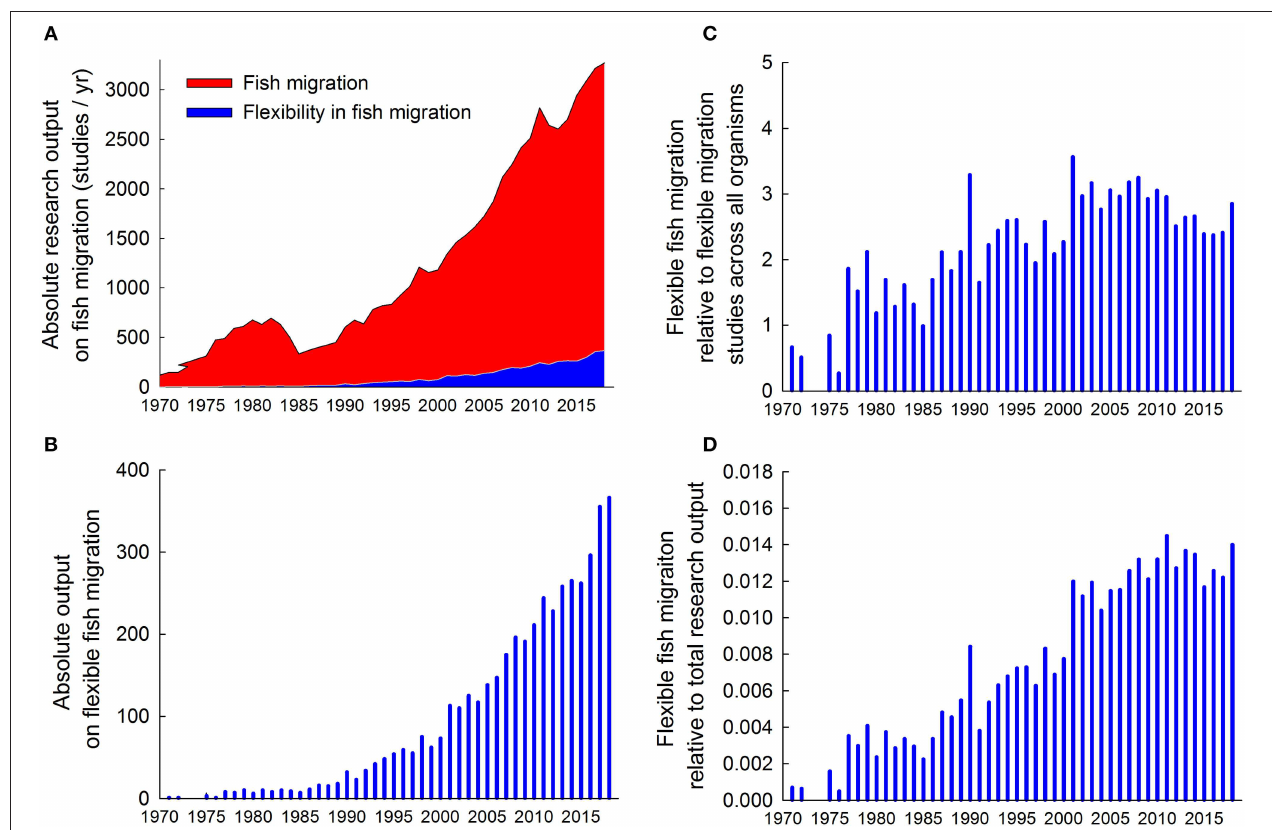
FIGURE 2 | Trends in research output on fish migration. (A) Absolute research output measured as publications on fish migration (red 1 ) and on flexibility in fish migration (blue 2 ) published per year up to December 2018. (B) Absolute research output on flexibility in fish migration 2 published per year. (C) Relative research output on flexibility in fish migration expressed as percentage of research output on flexibility in migration summed across all organisms 3 . (D) Relative research output on flexibility in fish migration 2 expressed as percentage of total research output summed across all scientific disciplines 4 . Data extracted from a topic search conducted 18 February 2019 from all databased in ISI Web of Science using the following search strings: 1 ((migrat* OR *dromous OR dispers*) AND (fish*)), generated 61,591 papers. 2 ((migrat* OR *dromous OR dispers*) AND (fish*) AND (plastic* OR flexib* OR partial OR alternat*)), generated 4,967 papers. 3 ((migrat* OR *dromous OR dispers*) AND (plastic* OR flexib* OR partial OR alternat*)), generated 172,489